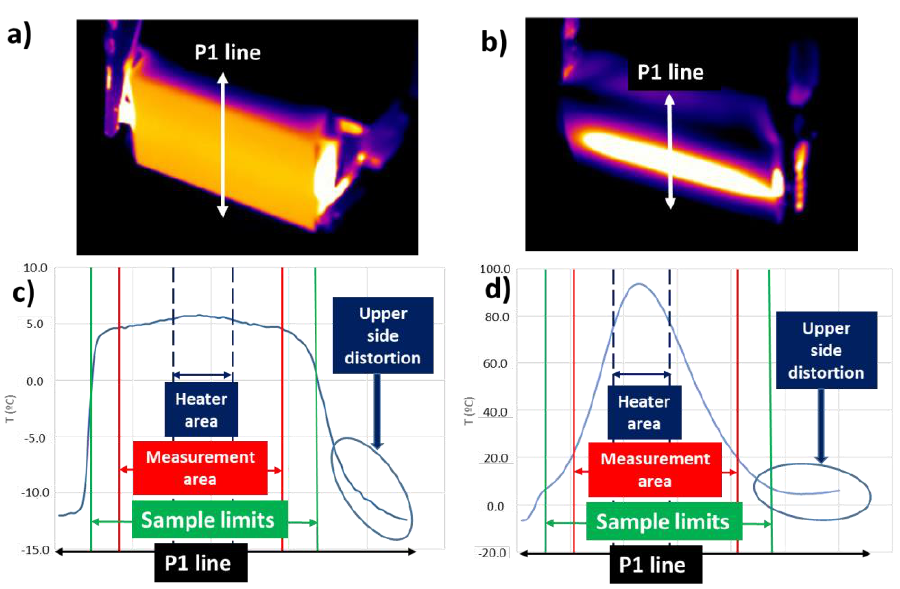
Figure 3. ( a ) and ( b ) show the studied temperature profile (P1 line) over the testing surface of alu- minum and PTFE, respectively. ( c ) and ( d ) illustrate the different zone limits needed to determine the measurement area.